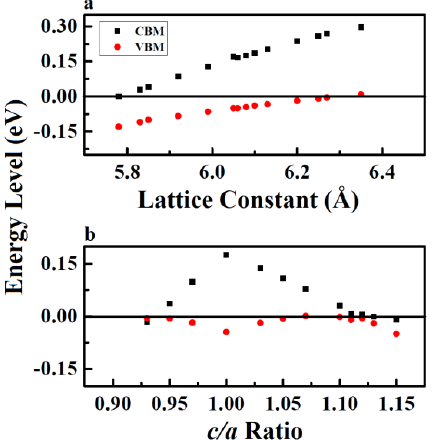
Figure 4. The energy of conduction band minimum (CBM) and valence band maximum (VBM) of the spin-down channel as a function of ( a ) the lattice constant and ( b ) the c / a ratio for Ti 2.25 Co 0.75 Si.